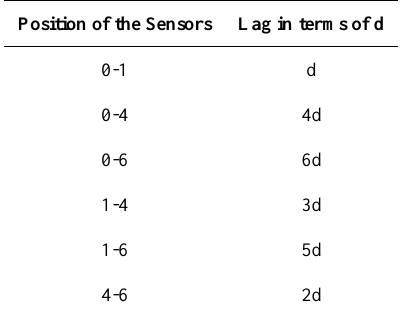
Table 1. Sensors position at 0, 1, 4, 6 and its corresponding